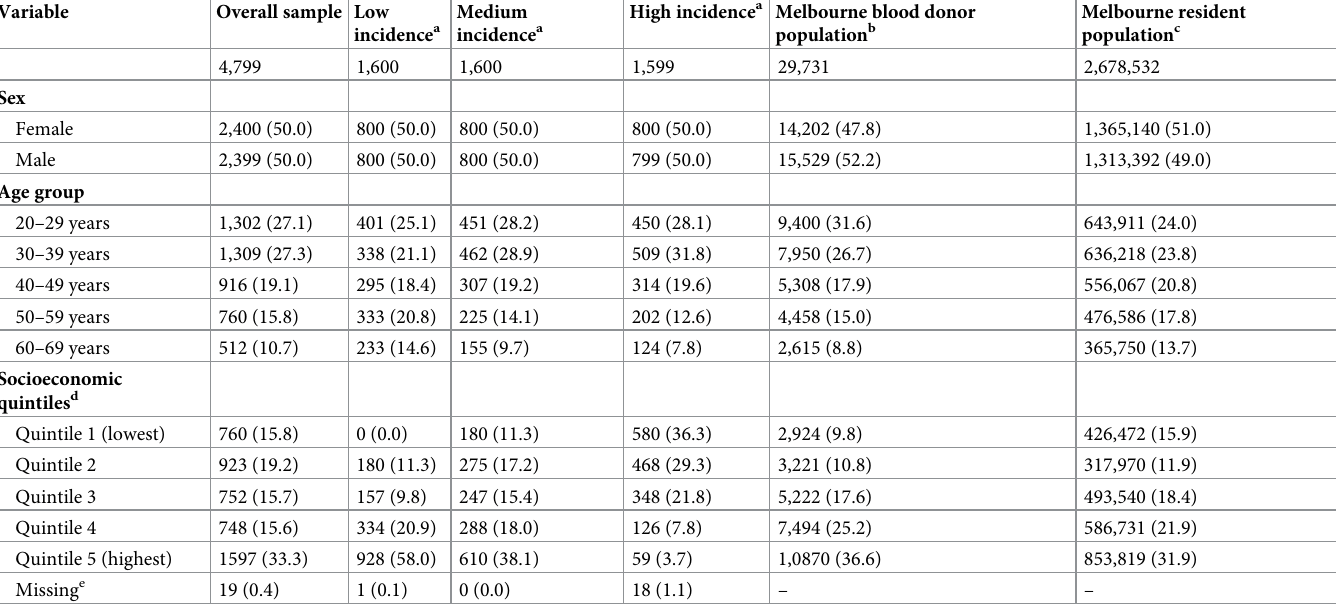
Table 1. Demographic characteristics of the study populations, by sampling stratum compared to Melbourne blood donors and residential populations aged 20–69